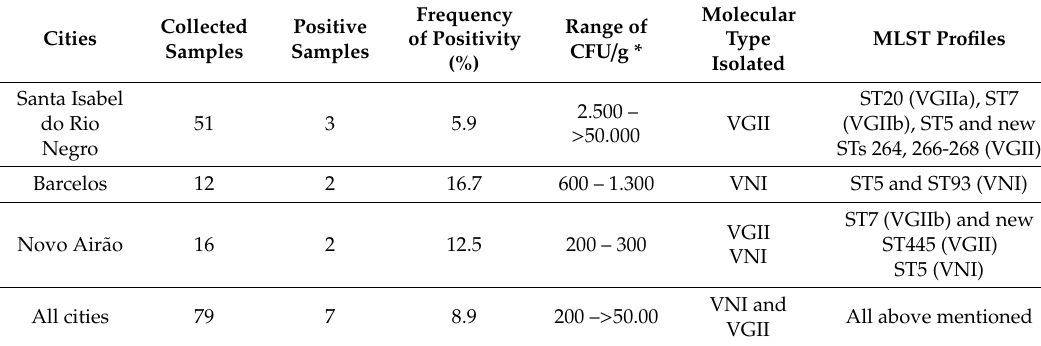
Table 1. Data of the cryptococcal isolation from indoor dust collected from the Rio Negro micro-region of the Brazilian Amazon, and molecular characterization ( URA5 -RFLP and MLST types) of the positive environmental samples.